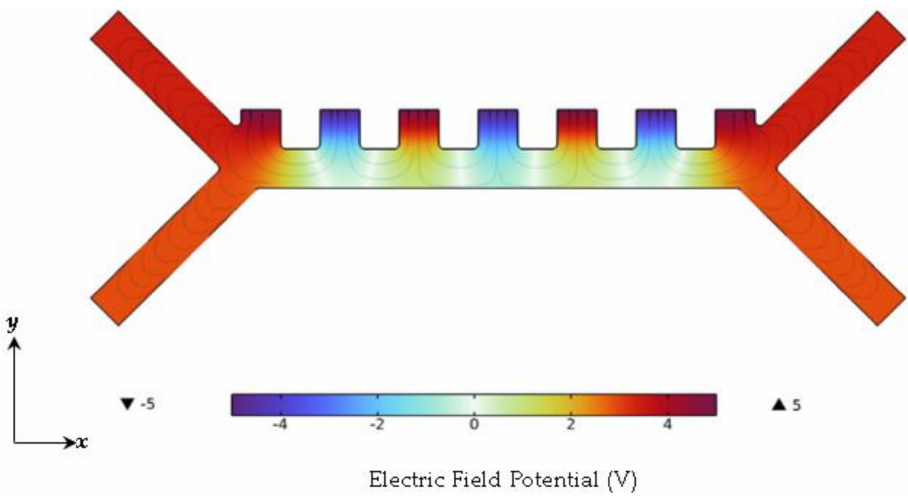
Figure 8. Contour of electric potential